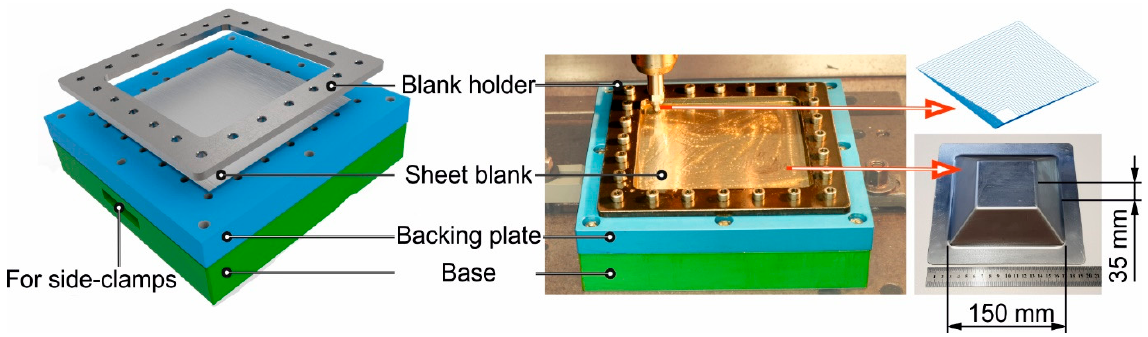
Figure 1. Experimental set-up of the single point incremental forming (SPIF) process. Table 1. Design of experiments (DoE).